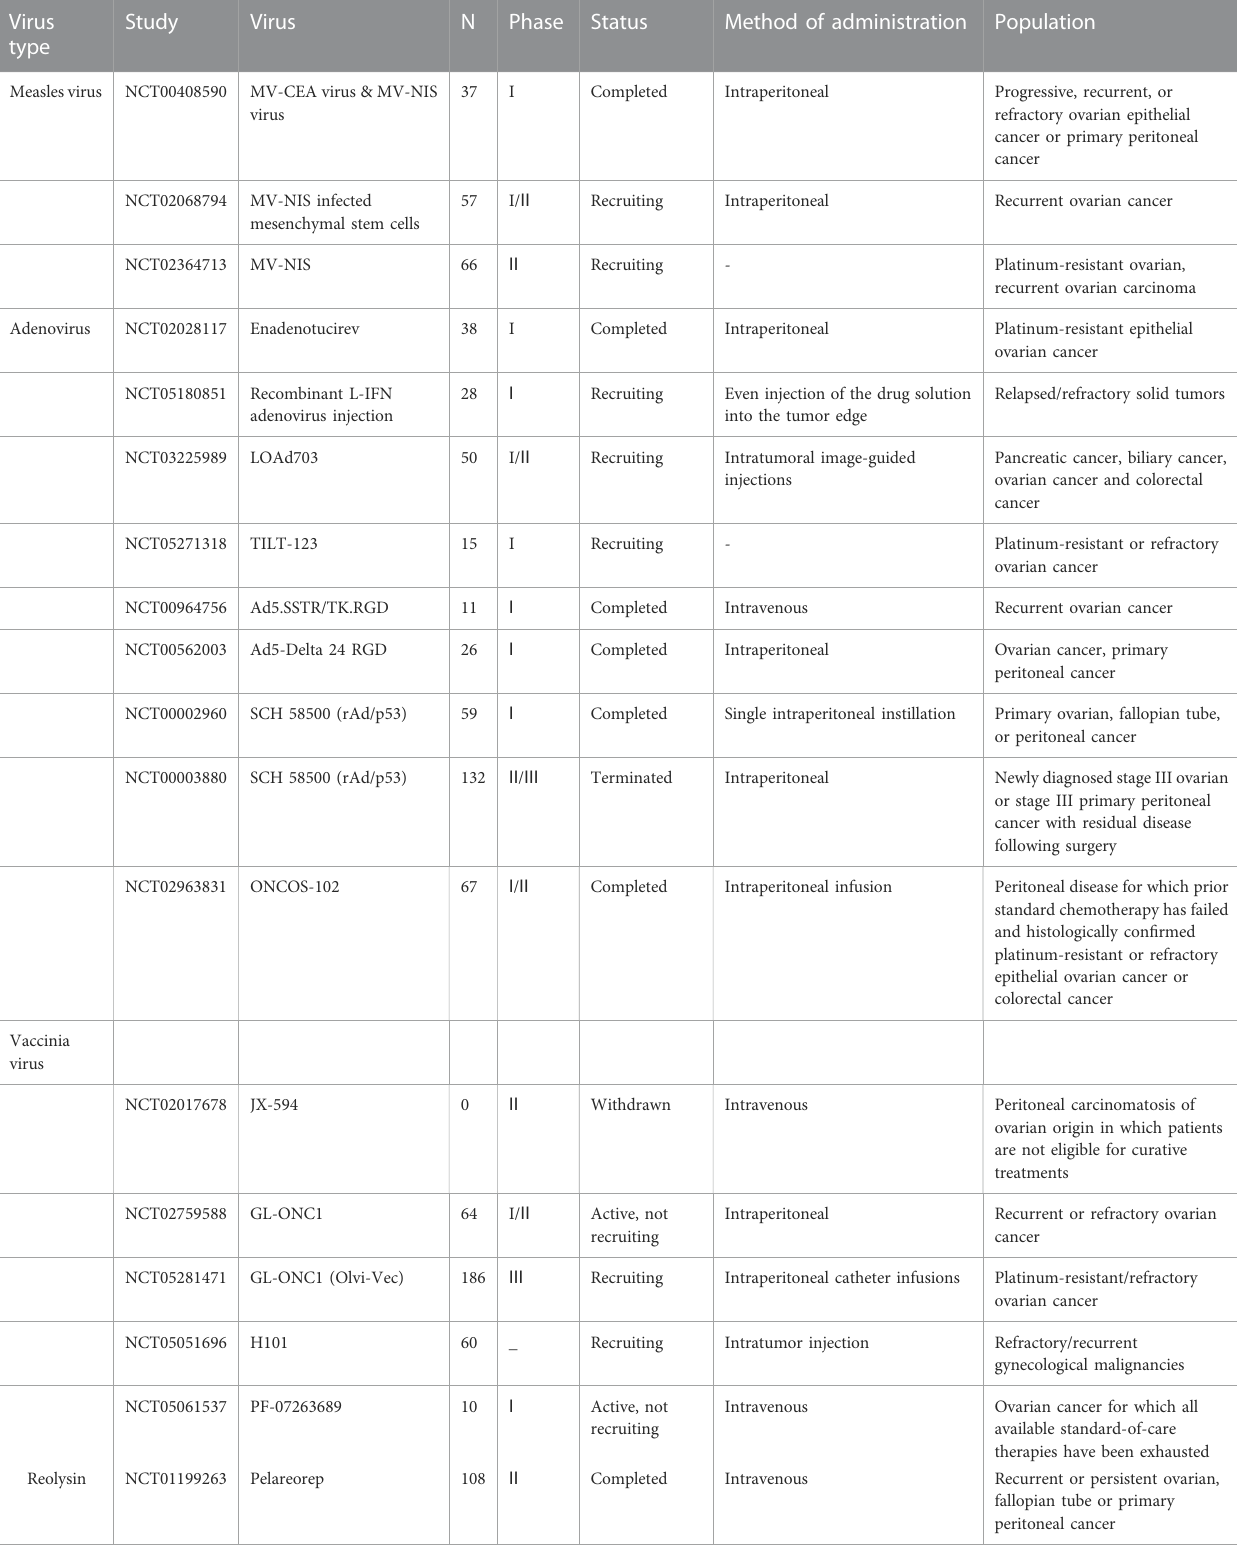
TABLE 4 Application of oncolytic viruses in the treatment of ovarian